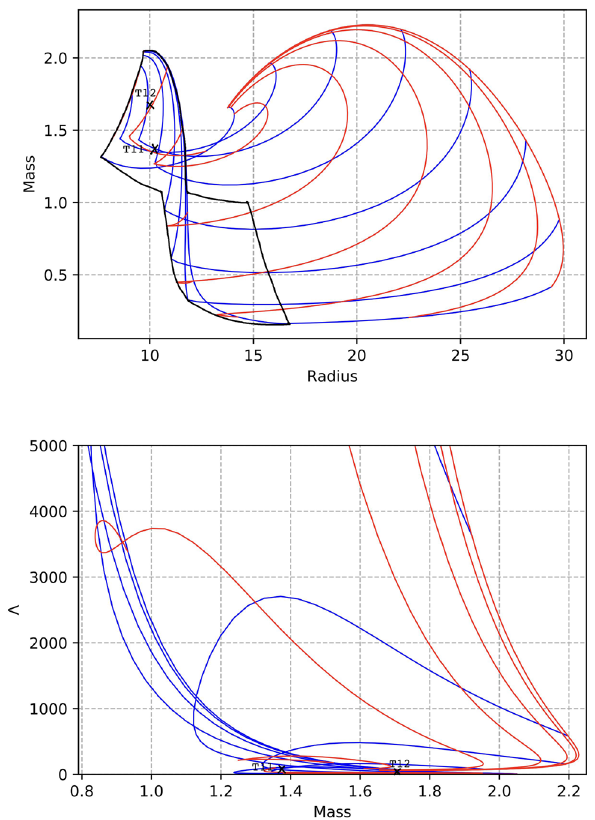
Fig. 9 Mass–radius(up)andTLN–mass(down)relationsofthehybrid stars of type (IIIa) and (IIIb) in Fig. 1 for SLy4 EoS and for dark matter EoS with B = 0 . 055. The region of stable configurations is specified by the black-encircled area. Different black lines correspond to different core pressures of dark matter but varying the core pressures of the nuclearmatter,andthebrownlinesaretheotherwayaround.Thecrosses indicate special stars T11 and T12 mentioned later in Table